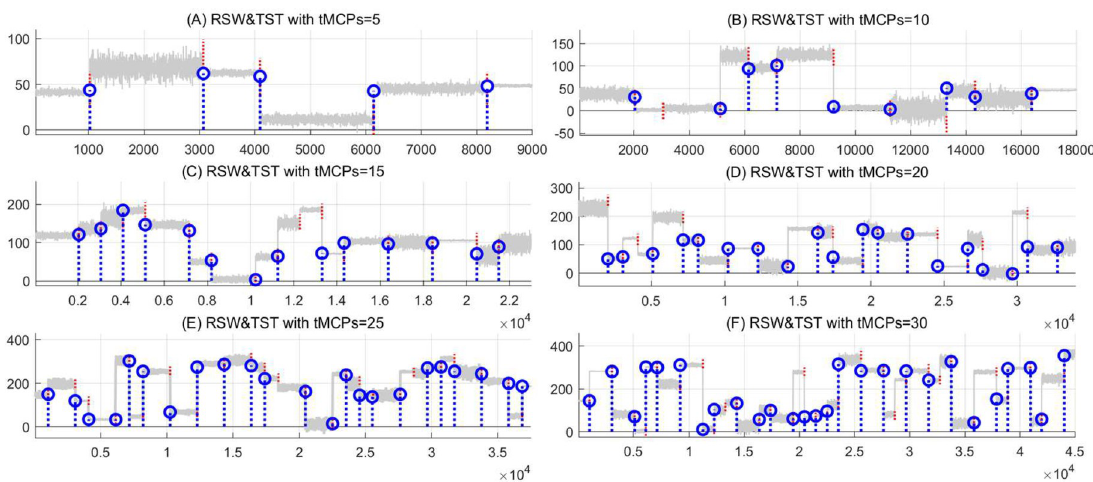
Fig 8. The simulations of MCPs detection under different numbers of t MCPs in the RSW&TST framework. For the synthetic time series with different t MCPs from 5 to 30, the results of MCPs detection are presented as (A) t MCPs = 5, (B) t MCPs = 10, (C) t MCPs = 15, (D) t MCPs = 20, (E) t MCPs = 25, and (F) t MCPs = 30, respectively.